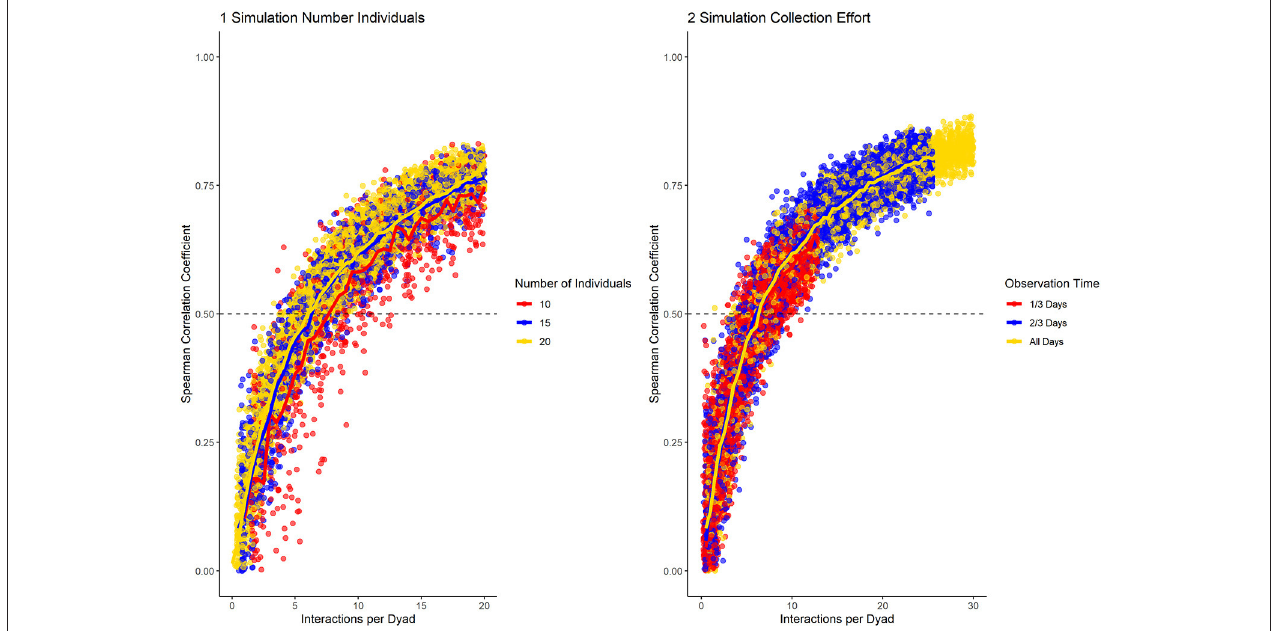
FIGURE 3 | Results of the data simulation with varying group size (1) and data collection density (2), while having medium fidelity of partner preference and no preference changes throughout the dataset. Horizontal line marks a correlation of halves of 0.5. The number of interactions per dyad allows to compare datasets of different density and number of individuals.